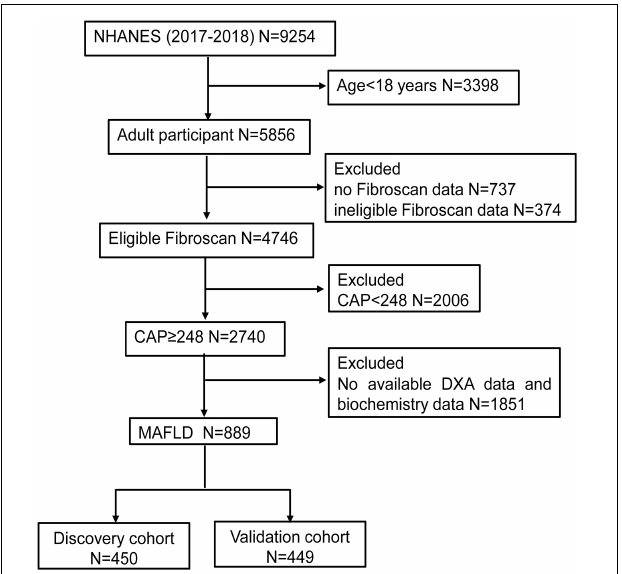
FIGURE 1 | The flow chart of participants selection. NHANES, National Health and Nutrition Examination Surveys; CAP, Controlled attenuation parameter; DXA, dual-energy X-ray absorptiometry; MAFLD, Metabolic associated fatty liver disease.